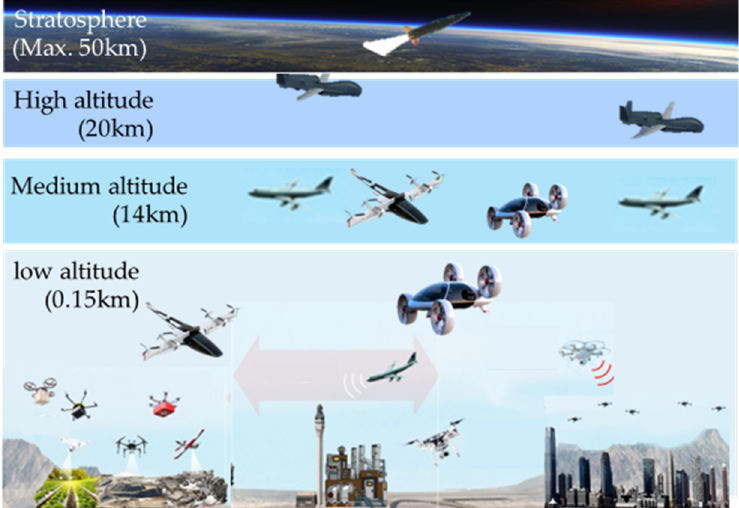
Figure 3. UAM classification according to operating altitude, KIAST.